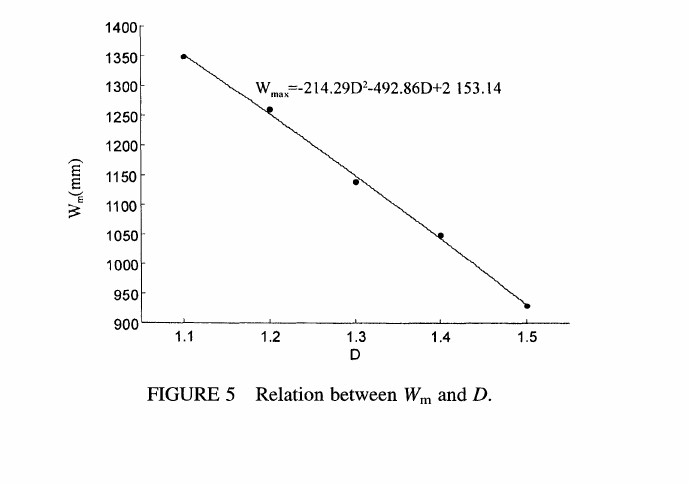
FIGURE 5 Relation between Wm and